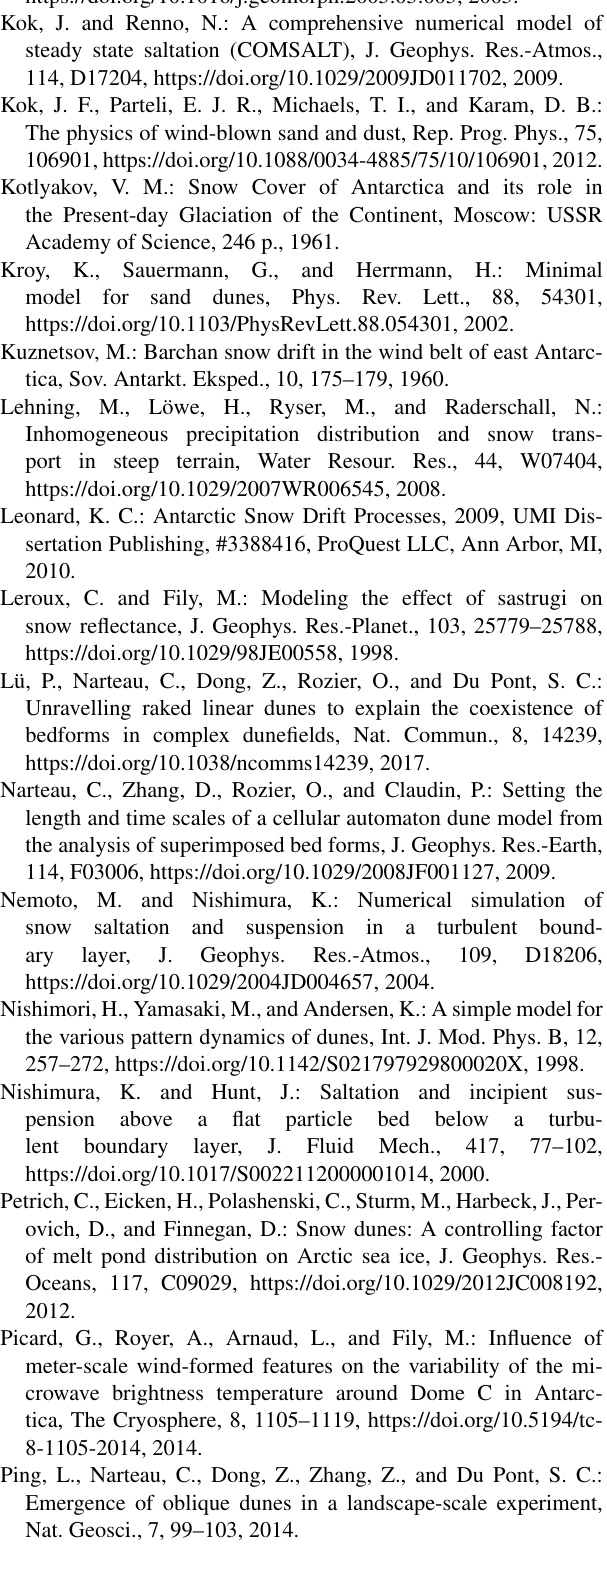
Tabler, R. D.: Controlling blowing and drifting snow with snow fences and road design, Tech. rep.,